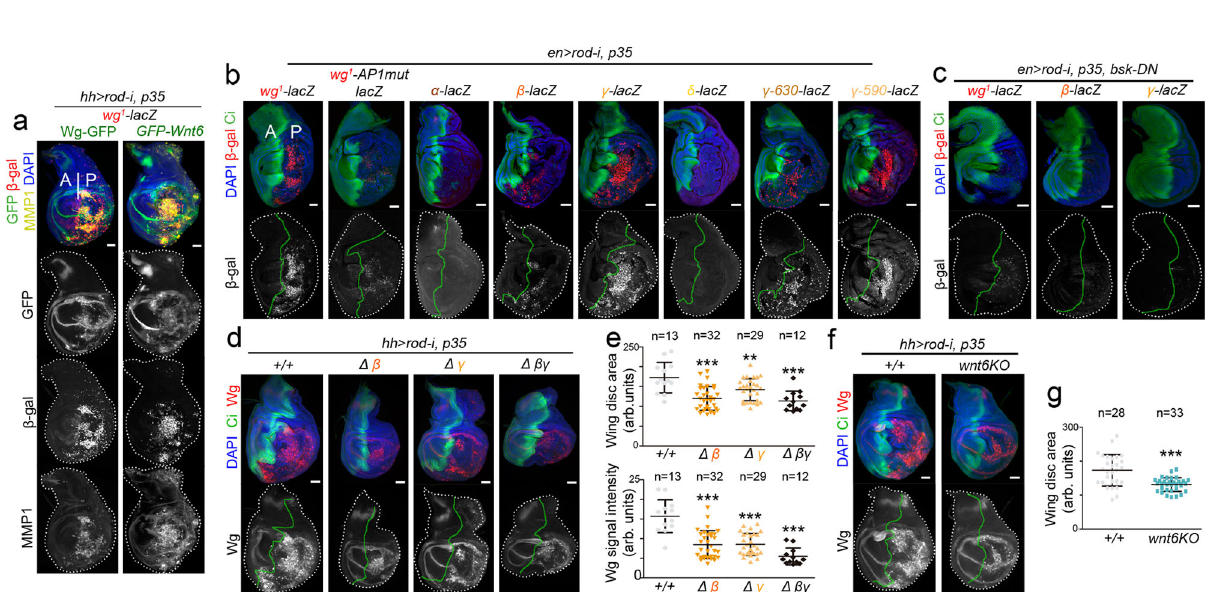
Fig. 7 | Functionally redundant CRMs in the wg 1 -enhancer respond to JNK and contribute to the growth of Chromosomal Instability-induced tumours. a – d , f Thirdinstarwingdiscsoflarvaebearingtheindicatedreporters,subjectedto theexpressionoftheindicatedtransgenesunderthecontrolofthe en-gal4 ( b , c )or hh-gal4 ( a , d , f ) drivers for four days and stained GFP ( a , green or white), ß- galactosidase ( a , b , c , red or white), MMP1 ( a , yellow or white), Wg ( d , f , red or white), Ci ( b , c , d , f , green), and DAPI (blue). Gal4 drivers are expressed in the posterior (P) compartment and Ci is used to label the anterior (A) compartment. WingdisccontoursarelabelledbywhitelinesandtheAPboundarybyagreenline.